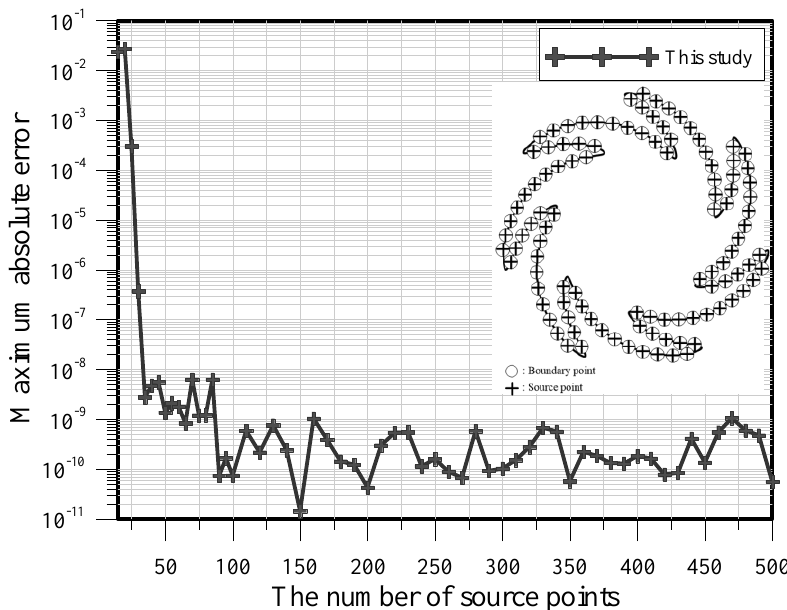
Figure 4. MAE versus the source point number.